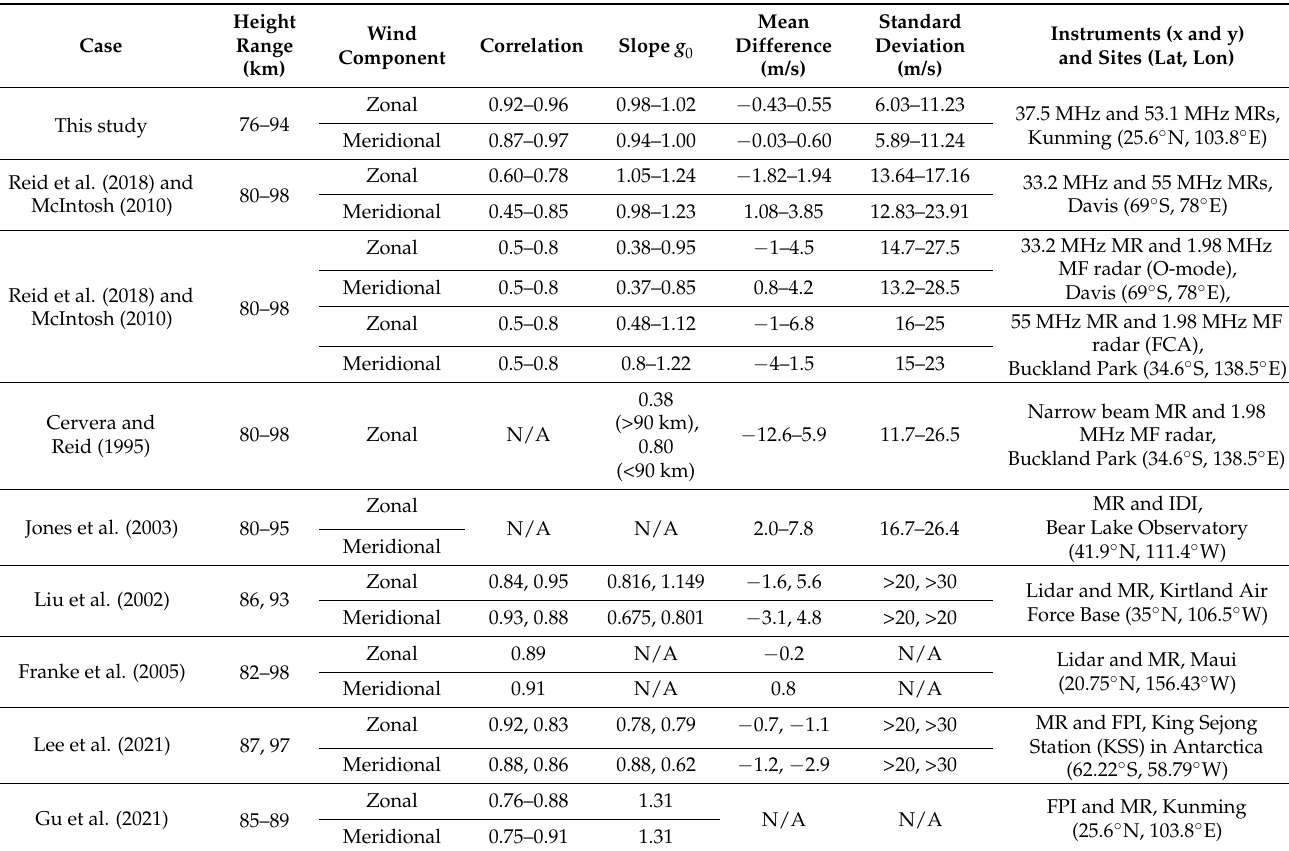
Table 2. Statistics of several comparison